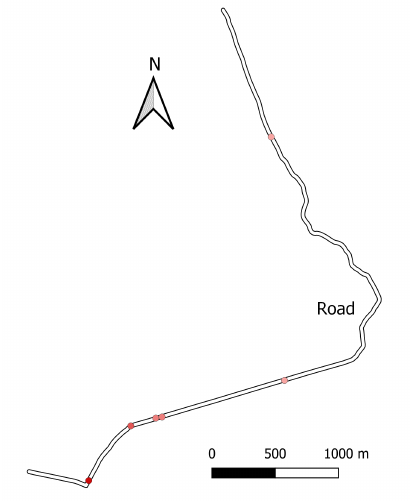
Figure 8. Result of Q5: the red points on the road. The